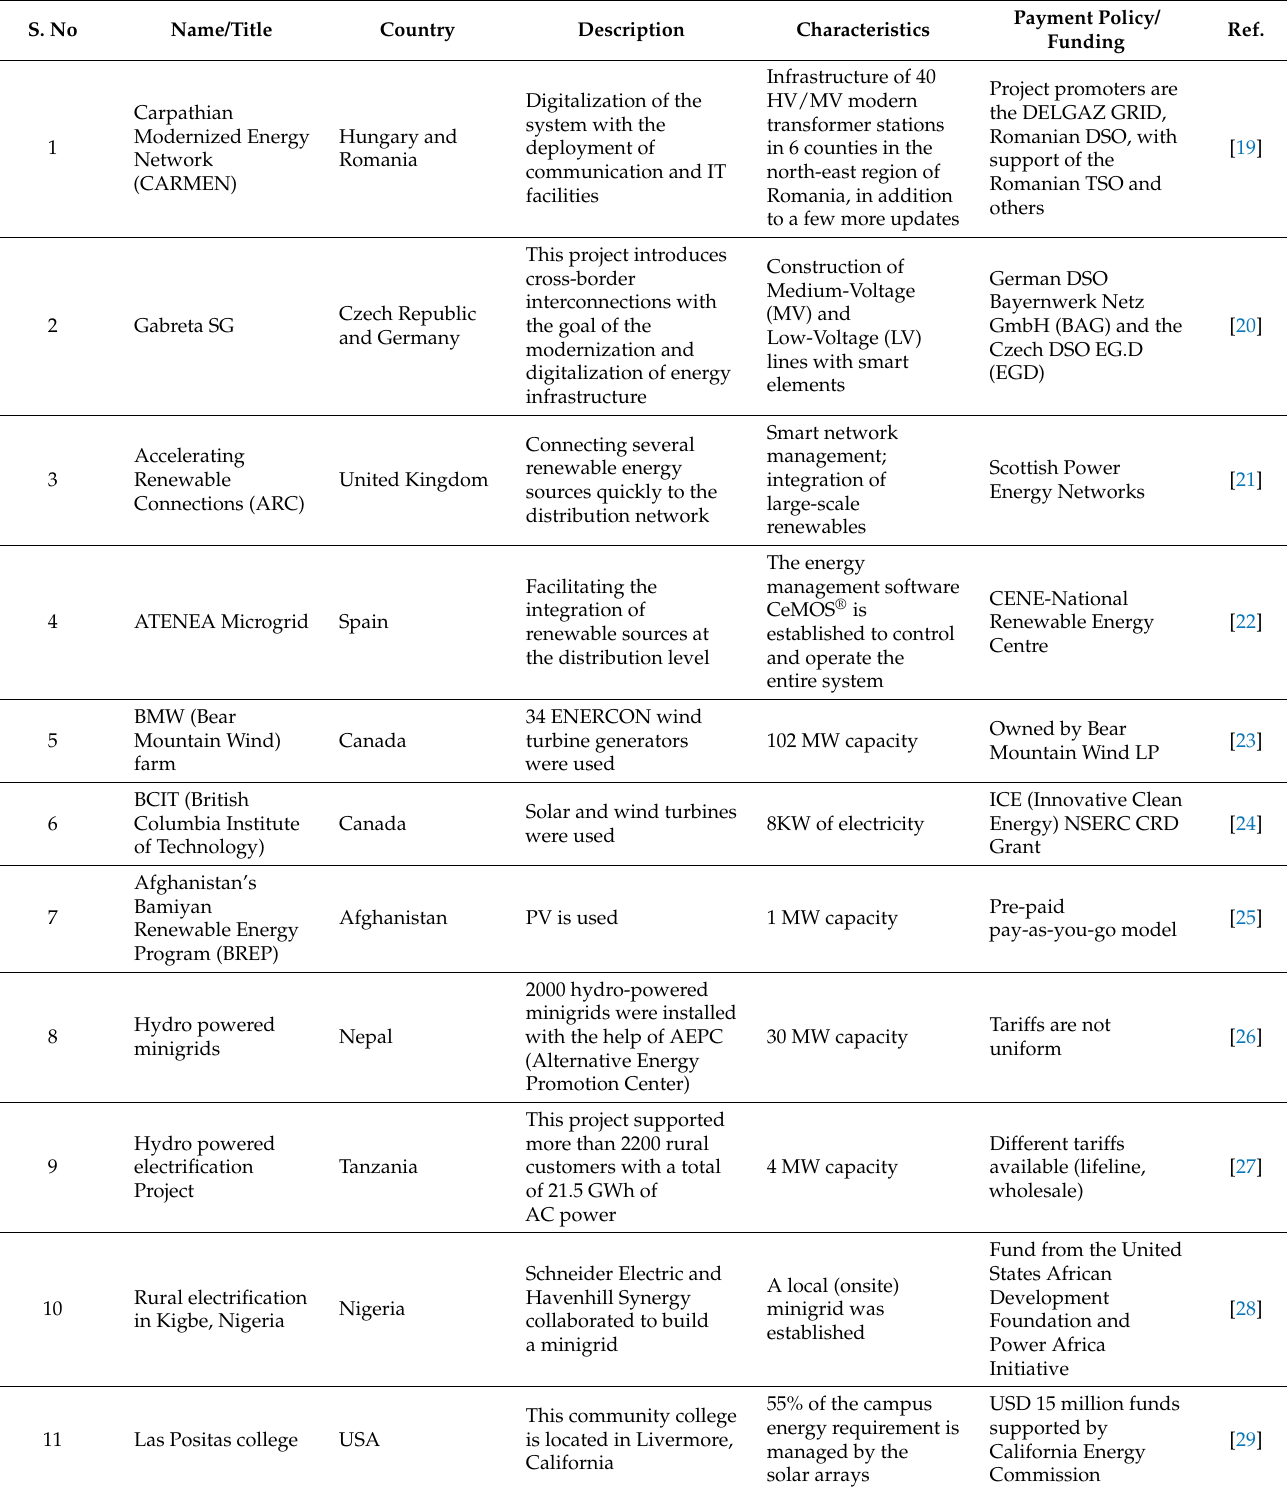
Table 2. Summary of worldwide